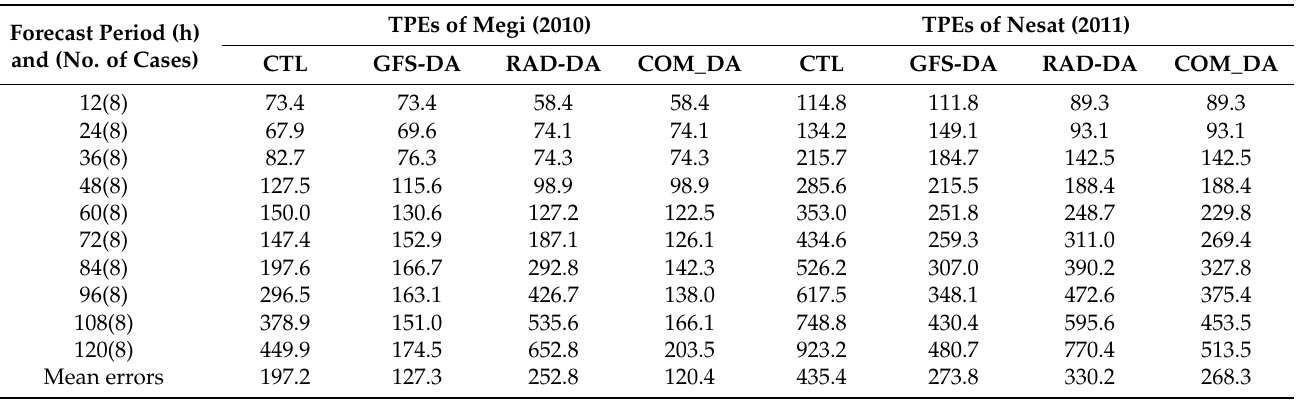
Table 4. Mean track forecast errors of Typhoon Megi (2010) and Nesat (2011) at different forecast periods for the CTL, GFS-DA, RAD-DA, and COM-DA runs (unit: